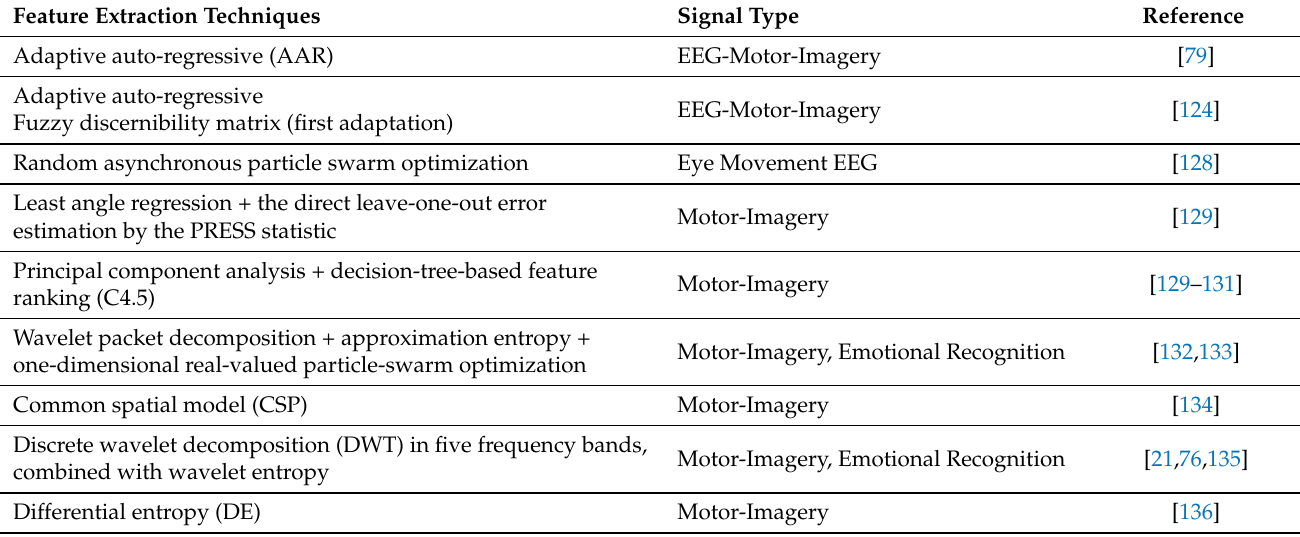
Table 4. A summary of feature extraction methods for PSG